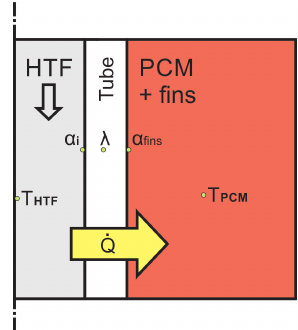
Figure 6. Heat transmission